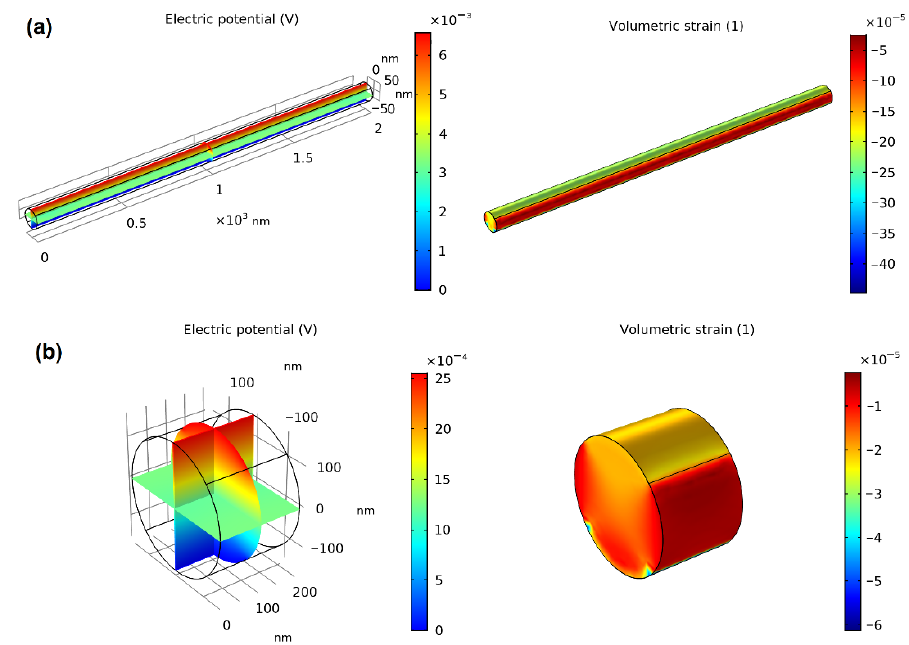
Figure 7. Simulated output voltage ( left ) and volumetric strain ( right ) of ( a ) a nanofiber with average diameter of 101 nm and length of 2000 nm and ( b ) nanofiber with average diameter of 315 nm and length of 206 nm.